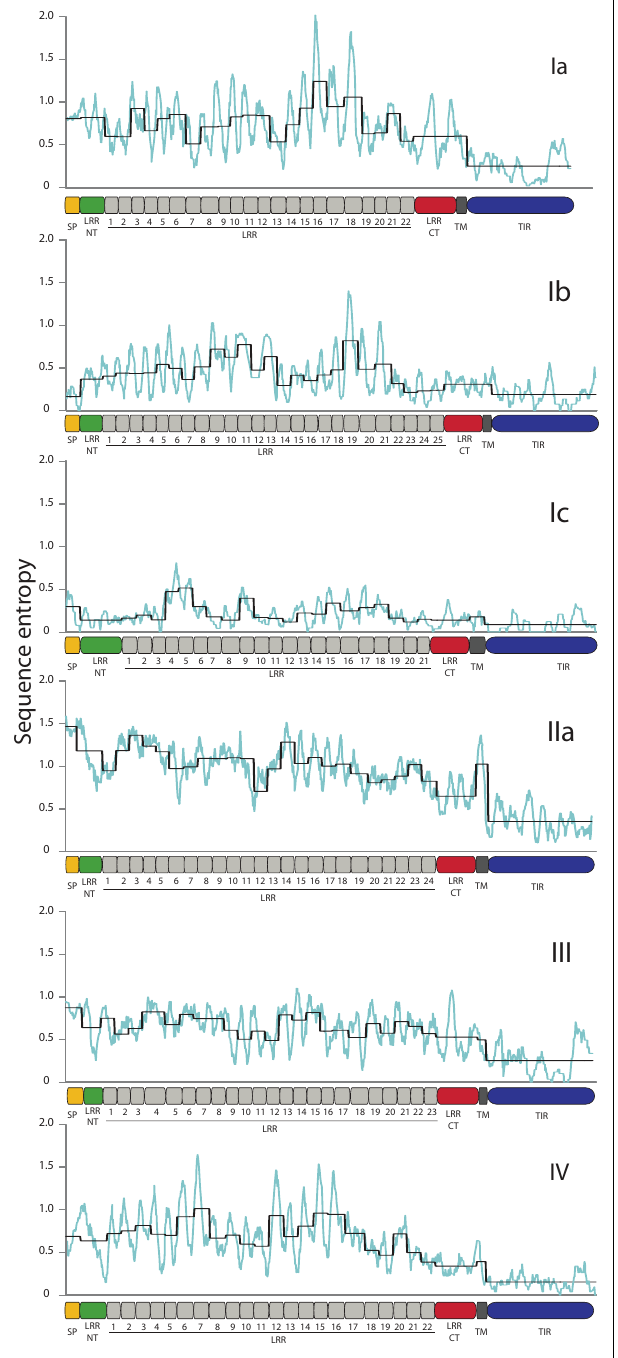
FIGURE 3 |TLRTIR domains are more conserved than the LRR regions. The diversity of the amino acid sequences for each of the subfamilies that contain more than eight complete sequences was analyzed as a measure of sequence entropy (Durbin et al., 1998). In the graphs shown, the light blue line indicates the average diversity over a sliding window of 10 amino acids, and the black line shows the average diversity of each of the protein domains marked on the x -axis. In each of the subfamilies, theTIR domains exhibit greater conservation than the ectodomains, and there is significant sequence variation within the LRR